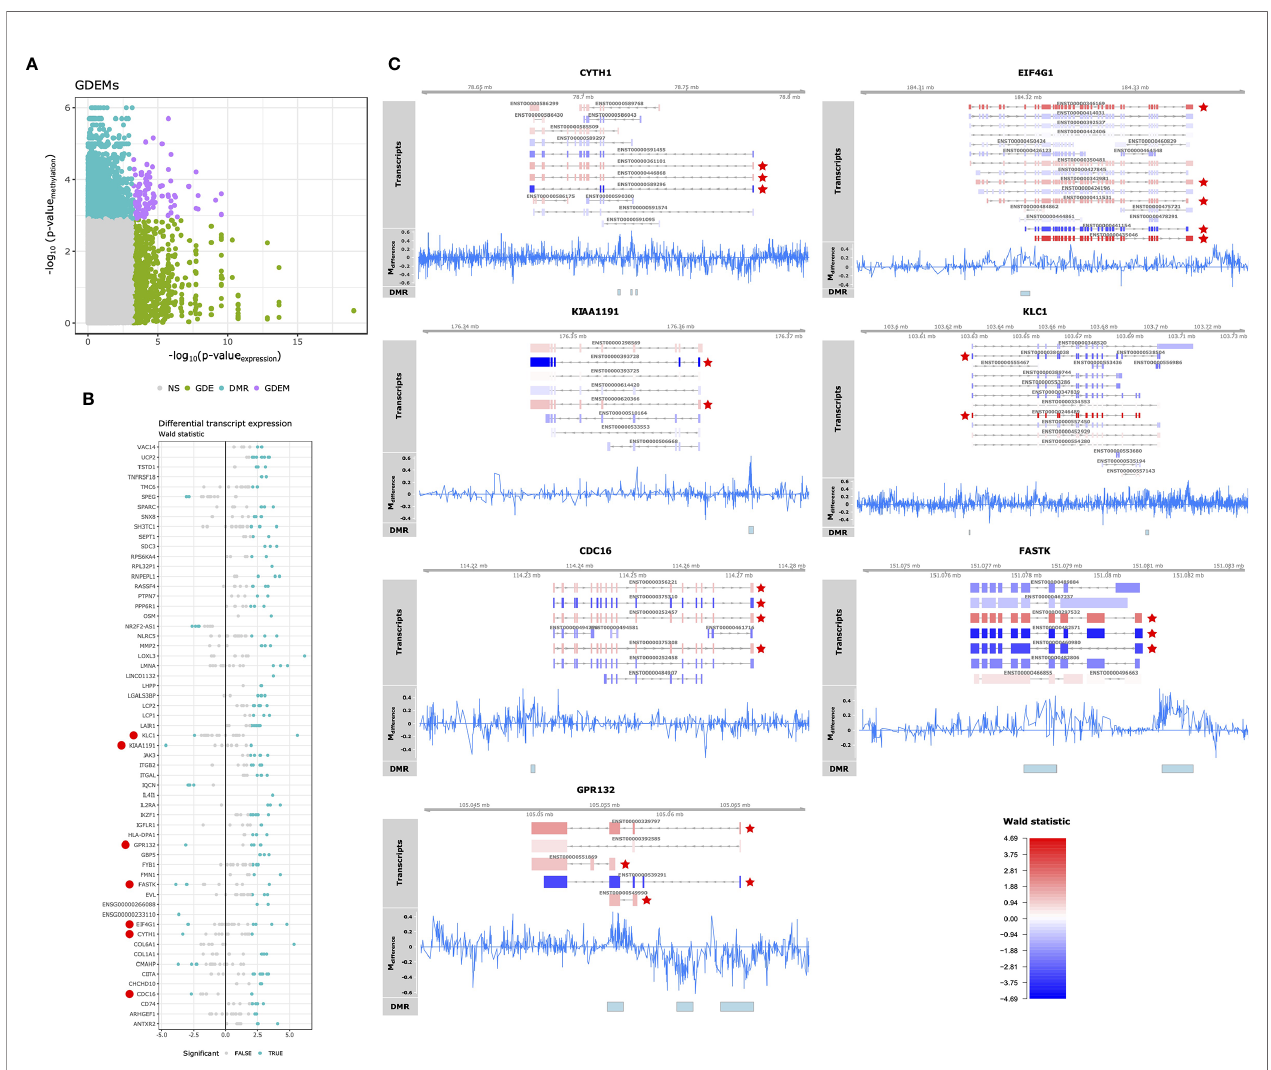
FIGURE 4 | Differential methylation and alternative splicing. (A) Comparison of the -log 10 ( p -values) obtained from gene differential expression analysis and differential methylation analysis on the x- and y-axis, respectively. Grey, green, blue and purple represent the genes: unchanged for methylation and gene expression ( “ NS ” ), differentially expressed ( “ GDE ” ), differentially methylated ( “ DMR ” ), differentially methylated and expressed ( “ GDEM ” ), respectively. (B) Visualization of the Wald statistic (a statistic calculated by DESeq2 representing the effect size relative to the variance) calculated for the individual transcripts (represented in dots) associated with each of the GDEMs. Grey and blue dots represent non-signi fi cant and signi fi cantly differentially expressed transcripts, respectively. Large red circles left of the gene symbols indicate genes with transcripts that display opposite effect sizes. (C) Summary visualization of the DNA methylation and gene expression signals for GDEMs: CYTH1, EIF4G11, KIAA1191, KLC1, CDC18, FASTK and GPR132. The “ Transcripts ” track represents individual transcripts coloured by the Wald statistic. Stars in red indicate differentially expressed transcripts. The “ M difference ” track represents the difference in percentage methylation when comparing SJC66 high with SJC66 low . The “ DMR ” track represents the locations of the DMRs as found by